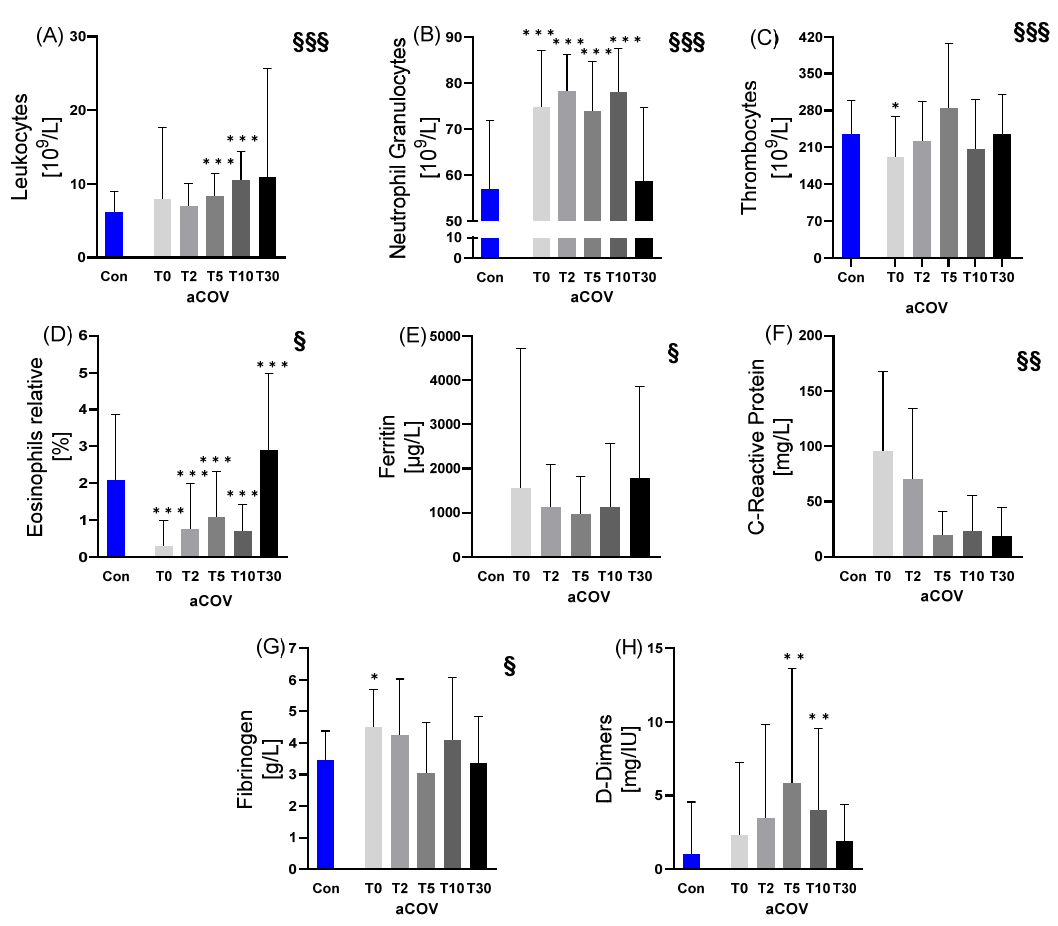
Figure 3. Immune cell and inflammation variables measured in acute COVID-19 infected individuals (aCOV) at different time points at the intensive care unit (T0 hospital admission; T2 day 2; T5 day 5; T10 day 10; T30 day) compared to healthy controls (Con). While ( A ) Leukocytes at T5 and T10, as well as ( B ) Neutrophil Granulocytes at T0–T10 were increased in aCOV compared to Con, ( C ) Thrombocytes were decreased at T0. The ( D ) relative proportion of Eosinophils was decreased between T0–T10 and increased at T30. ( G ) Fibrinogen at T0 and ( H ) D-Dimers (at T5 and T10) were increased compared to Con, and fibrinogen showed a significant change over time. Due to blood volume restrictions, no measurements could be made for ( E ) Ferritin and ( F ) CRP in Con, but intragroup analysis of aCOV showed for both, Ferritin and CRP, a significant change over time as well as highly increased values compared to clinical reference values [20,21]. * p ≤ 0.05; ** p ≤ 0.01;